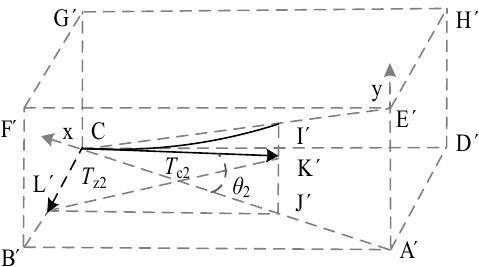
Figure 4. Analysis of the zigzag of the trolley wire on the right of the point C.